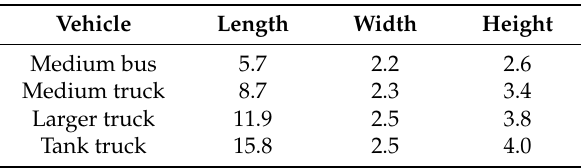
Table 2. The size of each vehicle (m).